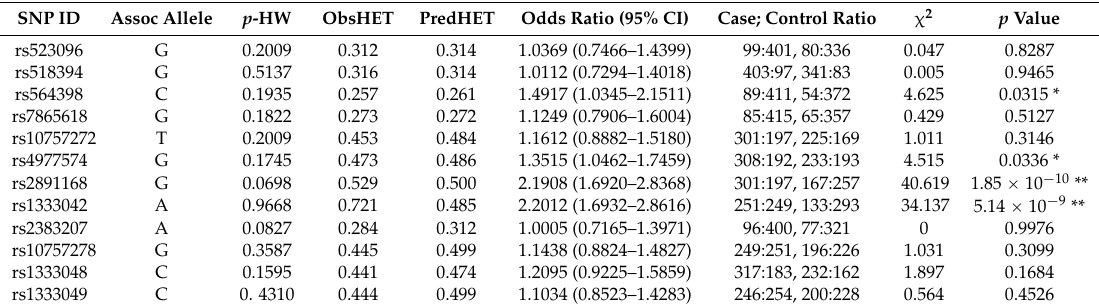
Table 2. Association of CAD with risk alleles of single nucleotide polymorphisms (SNPs) in 9p21.3 locus.